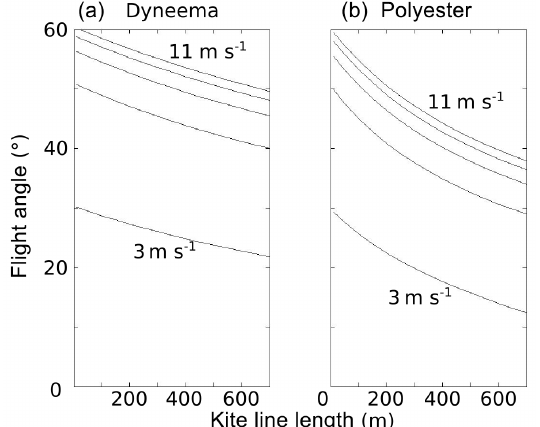
Figure 6. Simulation of the variation in flight angle with the line length for different winds and line materials. Simulations were performed with five wind speeds from 3 to 11ms − 1 in steps of